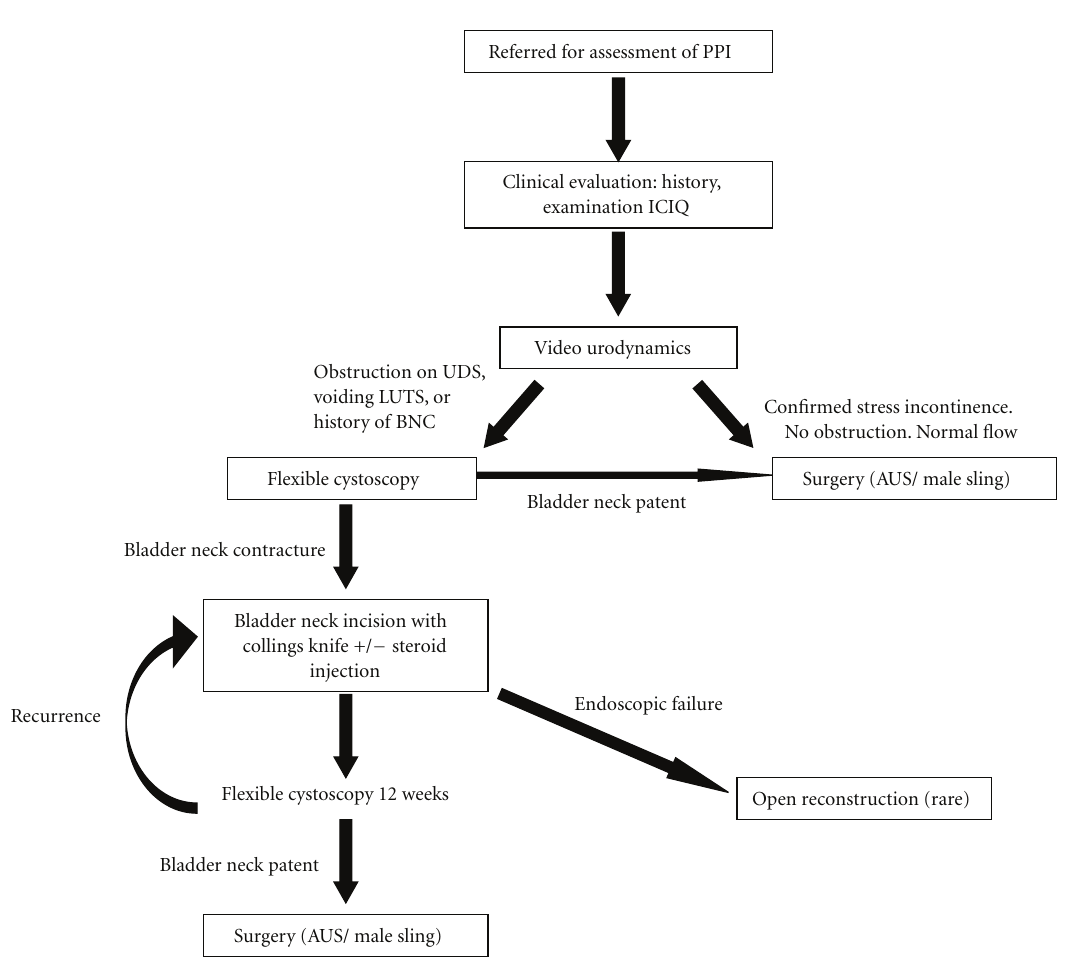
Figure 1: Our approach to management of PPI with concomitant